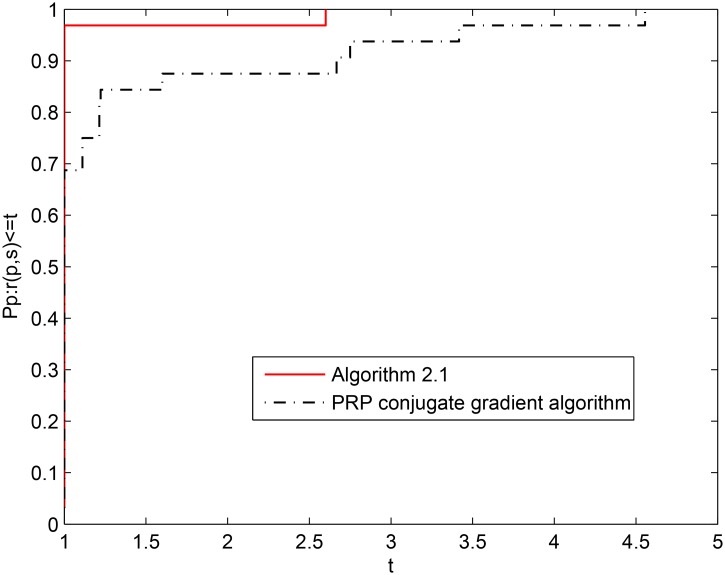
Performance profiles of the two algorithms (NFG).